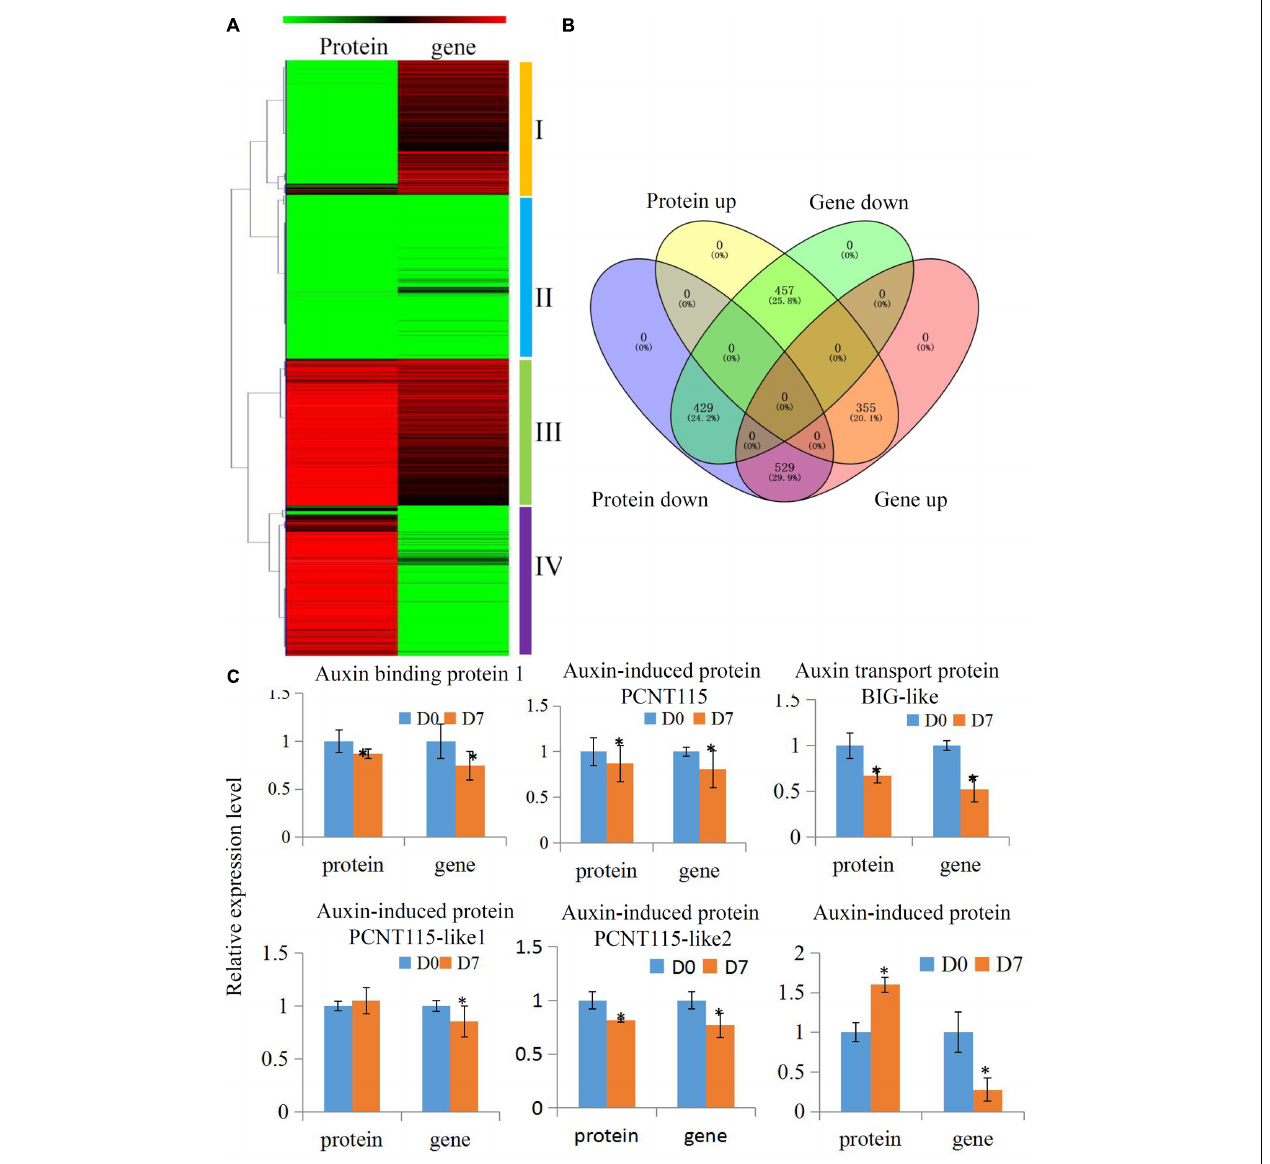
FIGURE 4 | Comparative transcriptomics and proteomics of hickory during grafting process. (A) Heat map for cluster analysis of the differentially expressed proteins combining with their transcripts by K-means method. Red indicates up-regulation and green indicates down-regulation. Proteins and transcripts were grouped into four groups based abundance values as follows: (I) proteins down-regulated and transcripts up-regulated; (II) proteins down-regulated and transcripts down-regulated; (III) proteins up-regulated and transcripts up-regulated; and (IV) proteins up-regulated and transcripts down-regulated. (B) Distinct expression regulation of proteins and transcripts was showed by a Venn Diagram. (C) Relative expression level of several auxin pathway proteins of hickory during grafting process. Significant differences in expression level were indicated by “ ∗